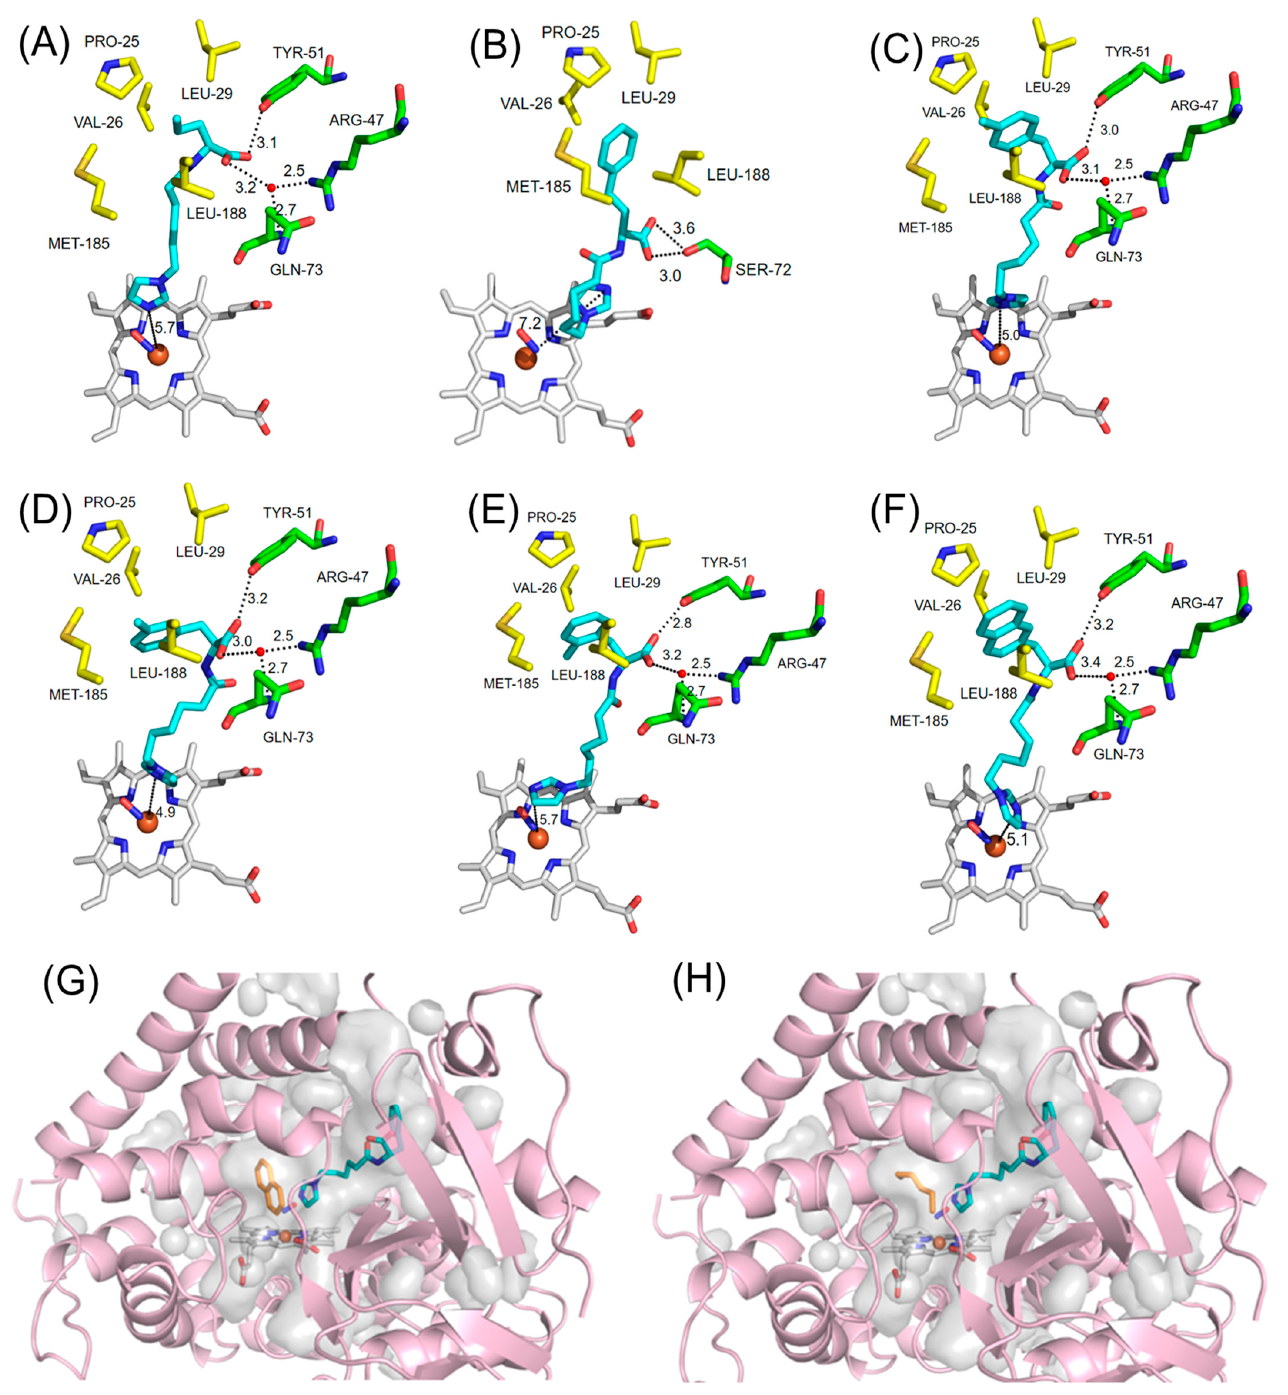
Figure 4. Docking simulation of DFSMs and substrates. ( A ) 2a ; ( B ) 2k ; ( C ) 2n ; ( D ) 2s ; ( E ) 2t ; ( F ) 2u ; ( G ) naphthalene; ( H ) hexane. The DFSMs, substrates, heme, hydrophobic binding pocket, and hydrophilic residues are shown as stick models colored in cyan, orange, white, yellow, and green, respectively. The iron atom and water molecule are shown as sphere models in orange and red, respectively. The cavities and pockets of the enzyme identified by Pymol are shown as surface models colored in light grey.